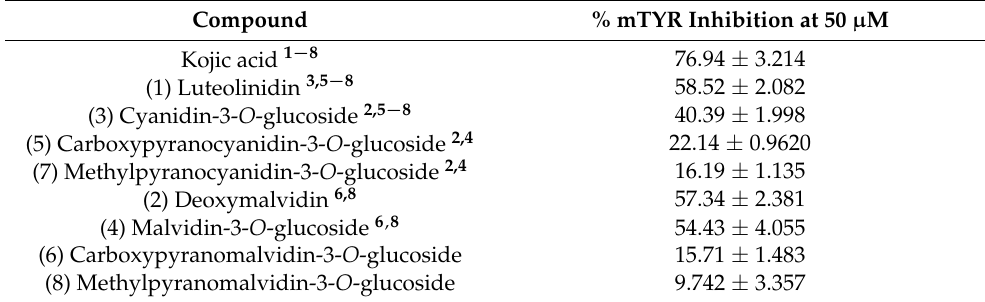
Table 1. Inhibition of mushroom tyrosinase by different anthocyanins and related compounds at 50 µ M. Superscripted numbers represent the groups (compounds) for which there are statistically significant differences ( p < 0.0001). Kojic acid was used as positive control. Each experiment was repeated at least 4